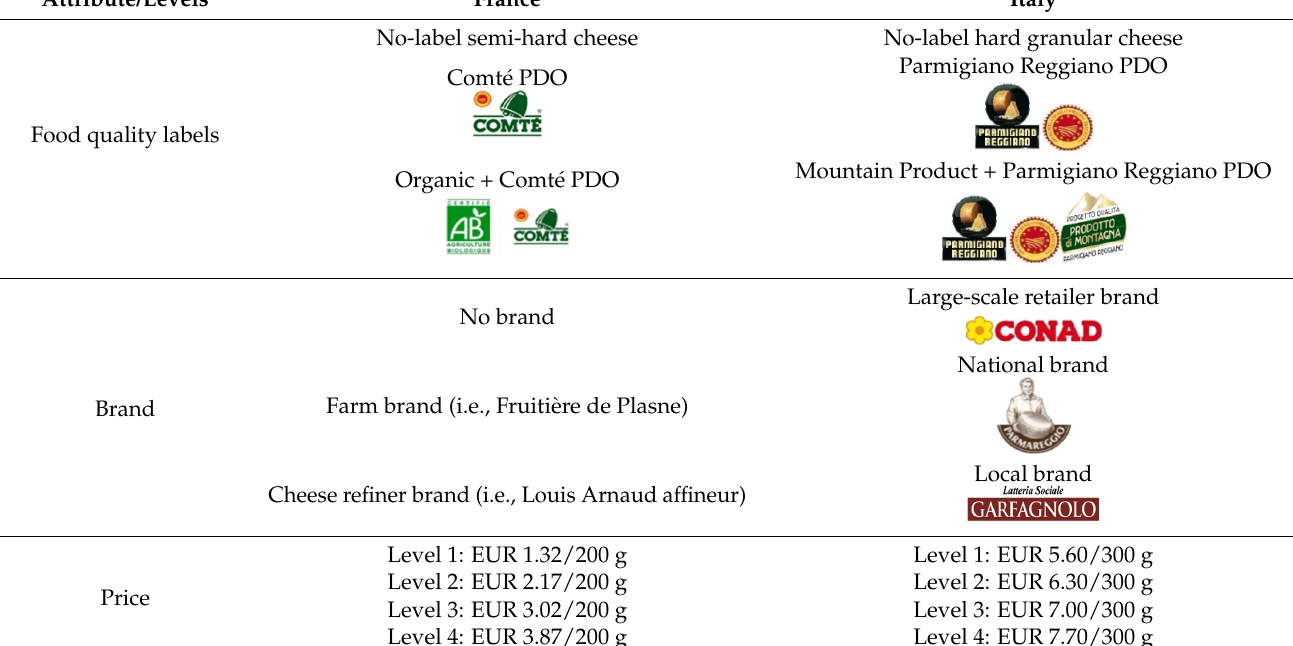
Table 2. Attributes and levels used in the DCE in France and Italy.